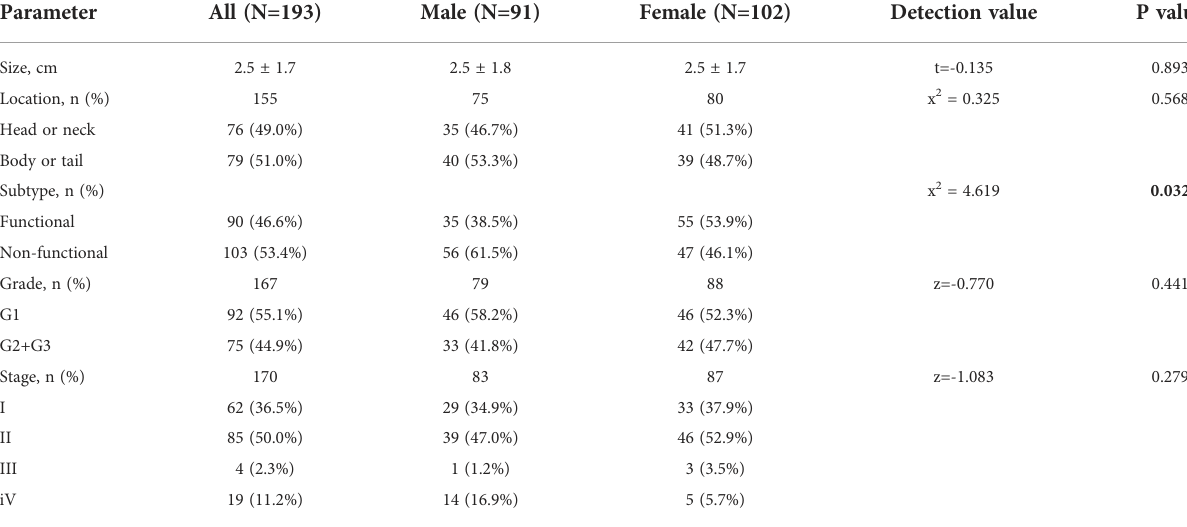
TABLE 2 Comparison of characteristics of tumors between different